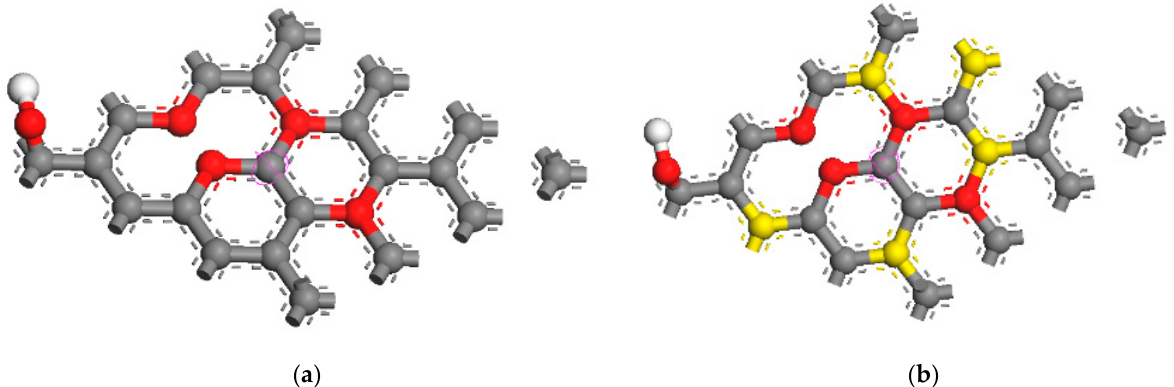
Figure 9. ( a ) Planform of GO module after geometry optimization and ( b ) planform of S-GO module after geometry optimization.